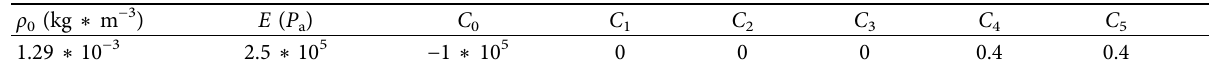
Table 4: Air material model and parameters of